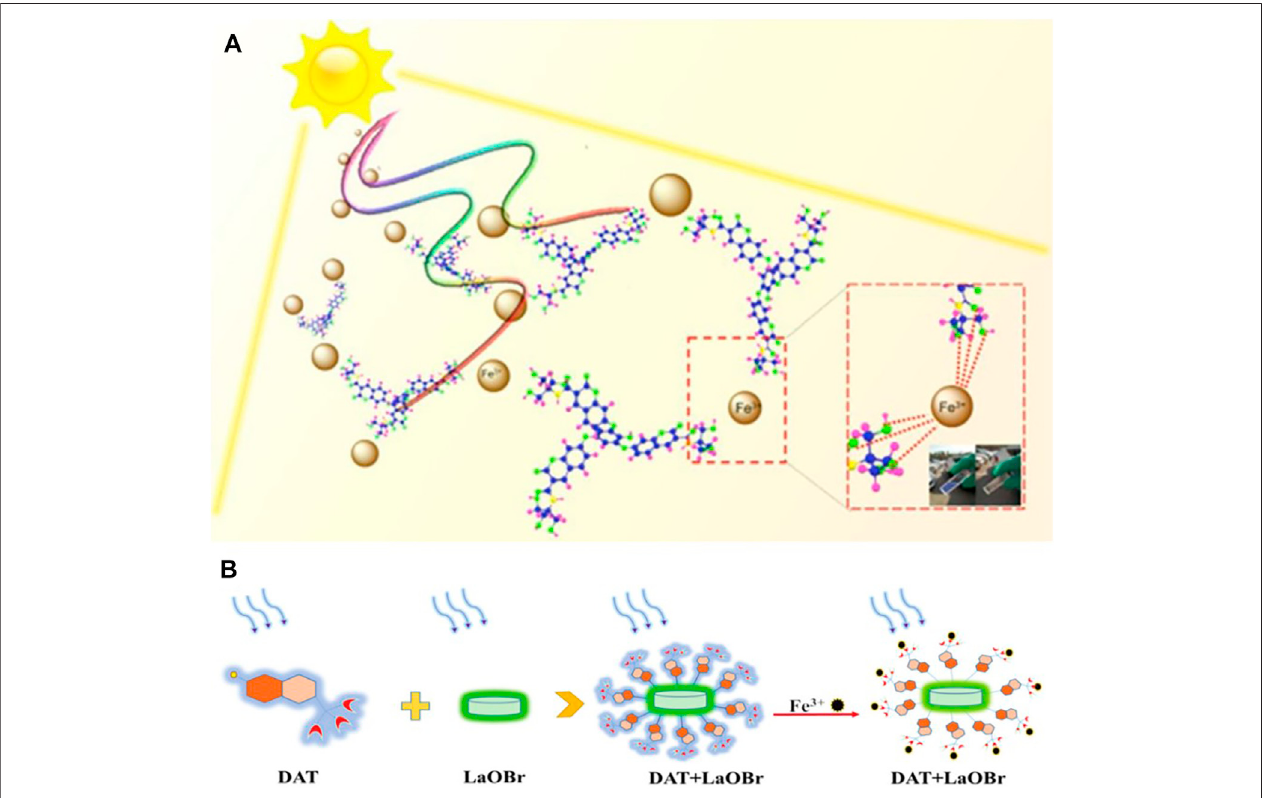
FIGURE 3 | (A) The trimeric phenolic coumarin (TPC) designed through the internal hydrophobic-external hydrophilic strategy achieves greatly enhanced Fe 3+ sensing performance, and can be used for naked eye detection with sunlight excitation (Liu J. et al., 2020); (B) A schematic diagram showing the preparation of the LaOBr/DAT [N-(2-hydroxy-1,1-bis (hydroxymethyl) ethyl)-7-hydroxycoumarin-3-carboxamide] composite and the mechanism of Fe 3+ sensing (Sun et al.,